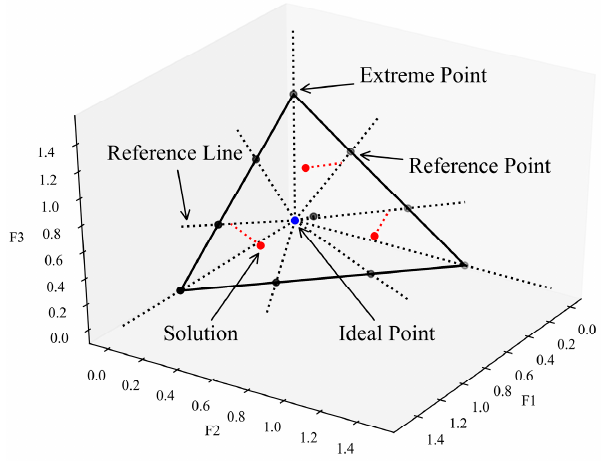
Figure 5. Sketch map of the niche-preserving operator.